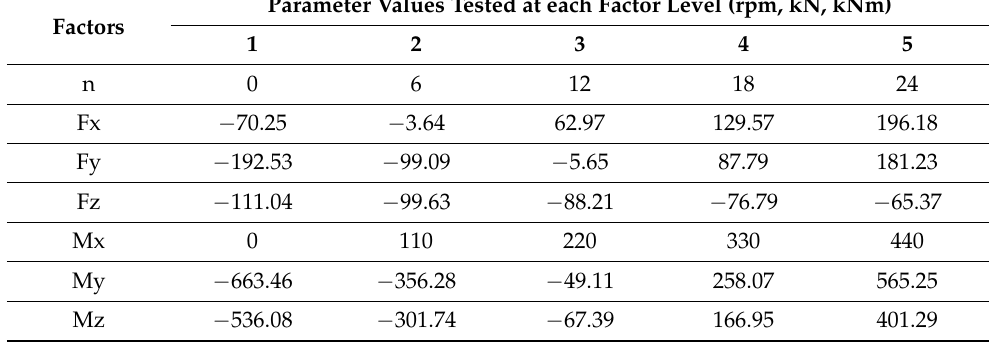
Table 7. Parameter values tested at each factor level.